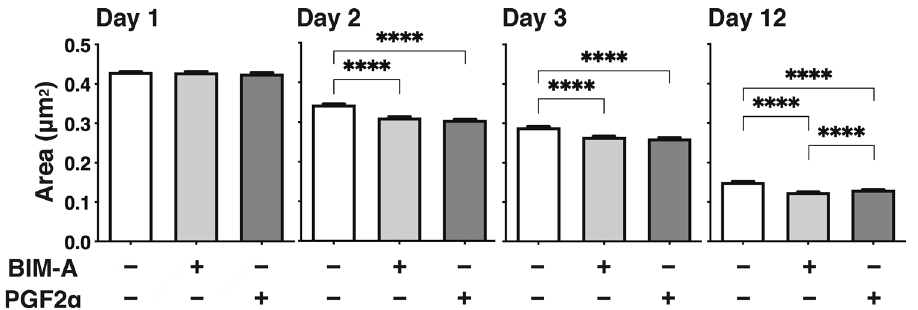
Figure 3. Changes in the sizes of three-dimension (3D) organoids of human orbital fibroblasts (HOFs) preadipocytes (DIF−) during the 3D cell culture in the absence or presence of Prostaglandin F2α analogues (PGF2α-ags). The mean sizes of the organoids of HOFs preadipocytes (DIF−) without or with 100 nmol/L Bimatoprost acid (BIM-A) or 100 nmol/L PGF2α were measured at Day 1, 2, 3 or 12, and compared among the treatment groups. All experiments were performed in triplicate using fresh preparations consisting of 16 organoids each. Data are presented as arithmetic means ± standard error of the mean (SEM). **** P < 0.001 (ANOVA followed by a Tukey’s multiple comparison test).